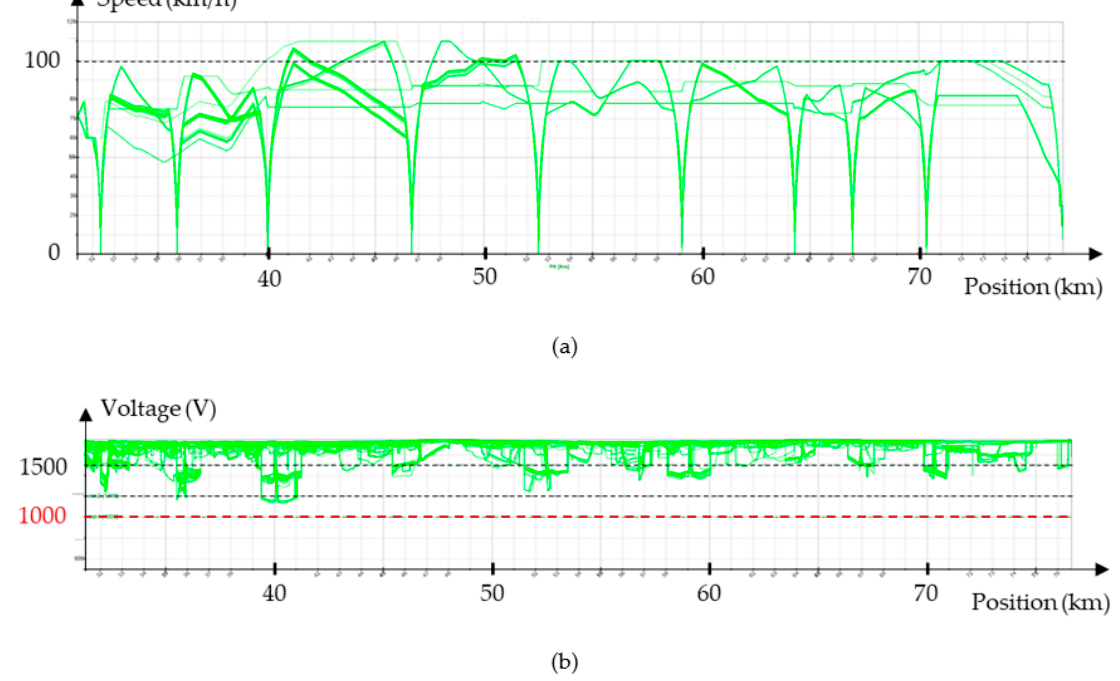
Figure 15. Simulation results in the nominal situation: ( a ) speed; ( b ) catenary voltage of the trains on line 5.